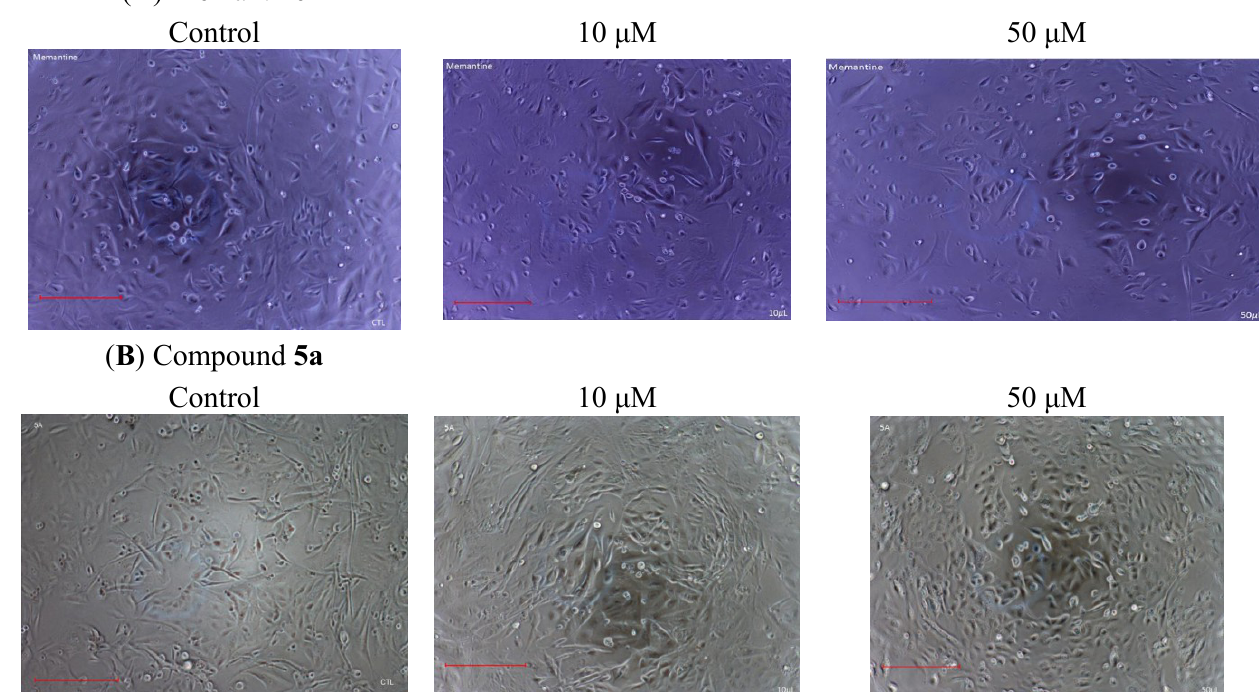
Figure 3. Macrographs using phase contrast microscopy of single point screen at 10 and 50 μM of test compound on MDCK